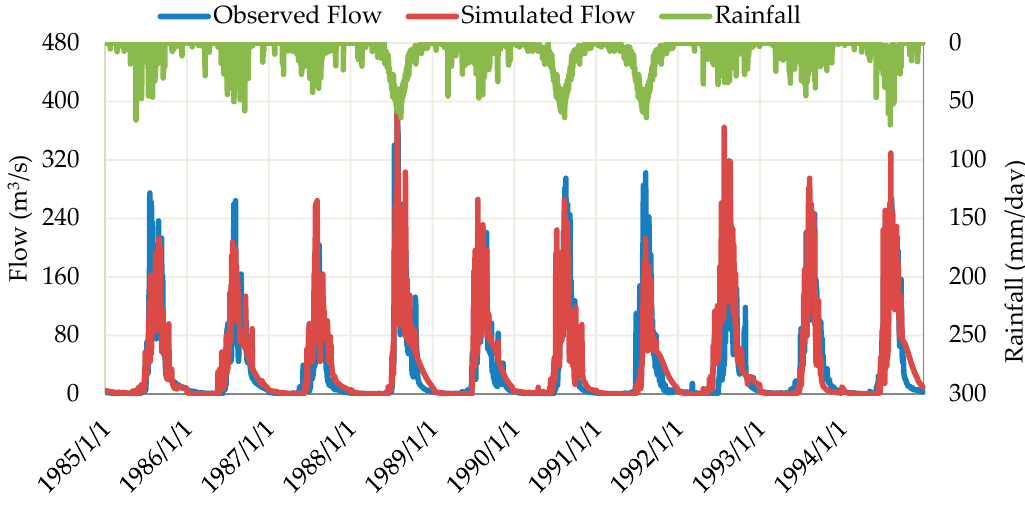
Figure 5. Comparison of simulated and observed flow for the calibration period (1985–1994).